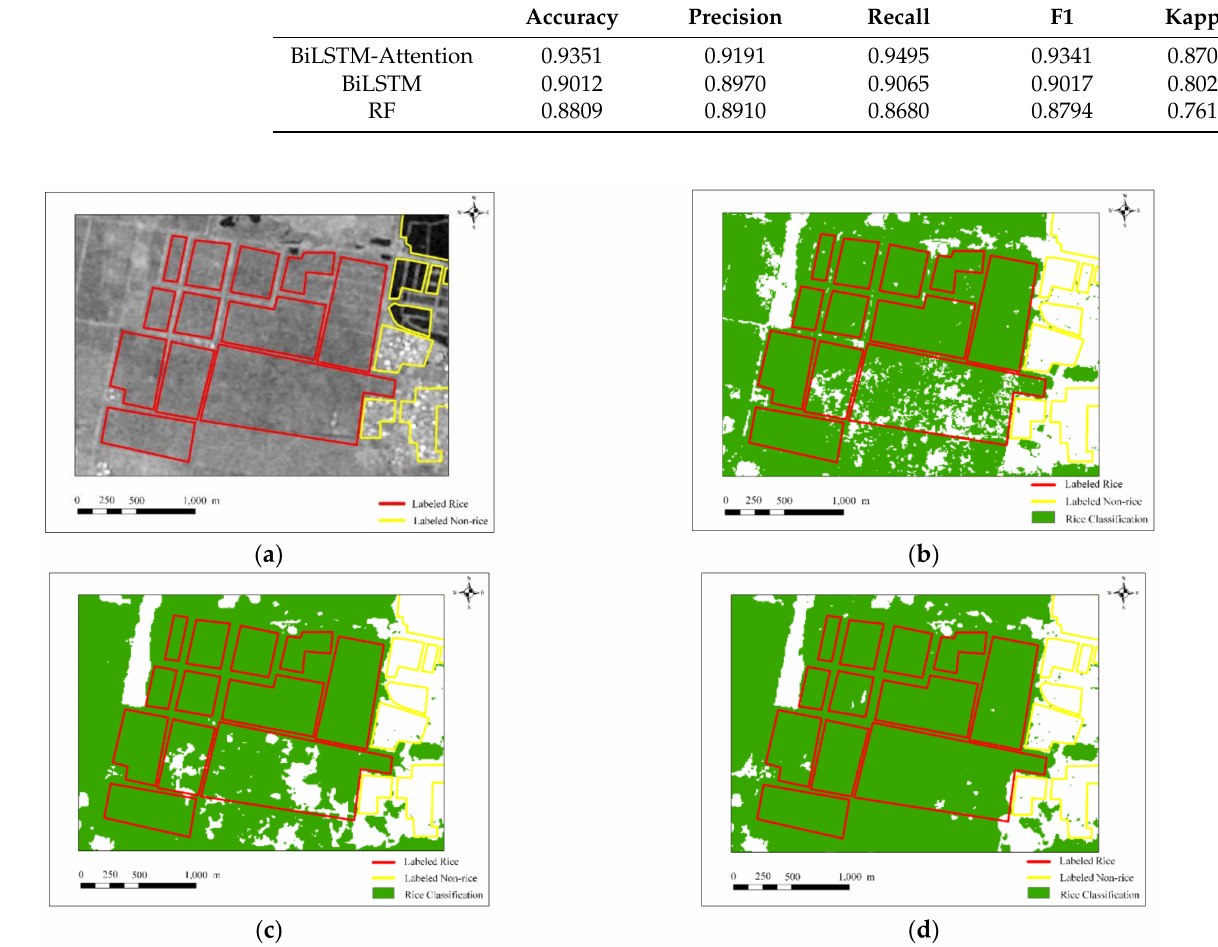
Figure 11. Comparison of classification results of different methods. ( a ) Label; ( b ) RF; ( c ) BiLSTM; ( d )